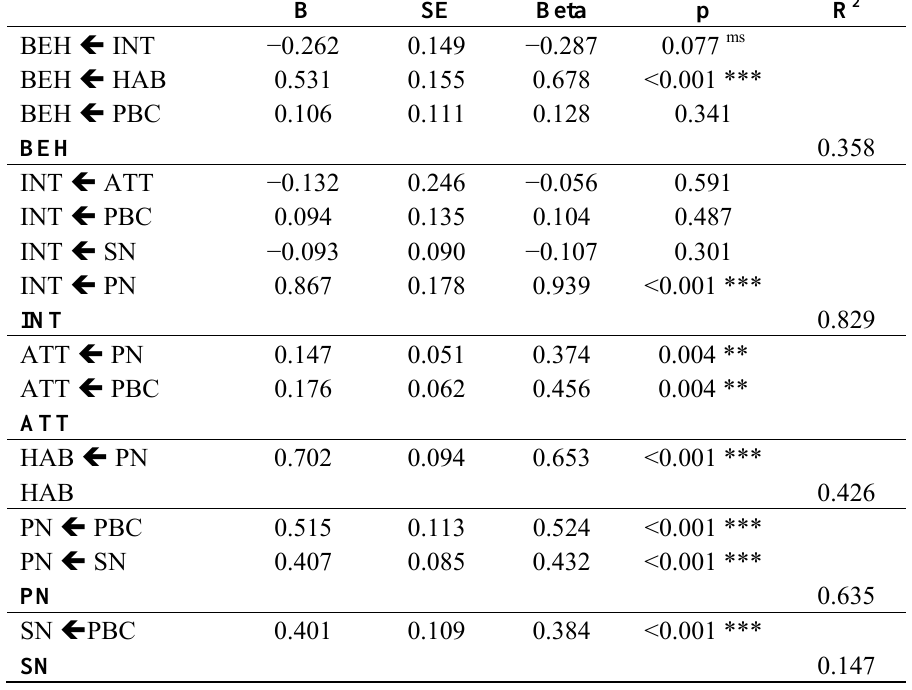
Table 2. Unstandardized and standardized regression weights, standard errors, p-levels, and estimated R 2 of the structural model ( N =